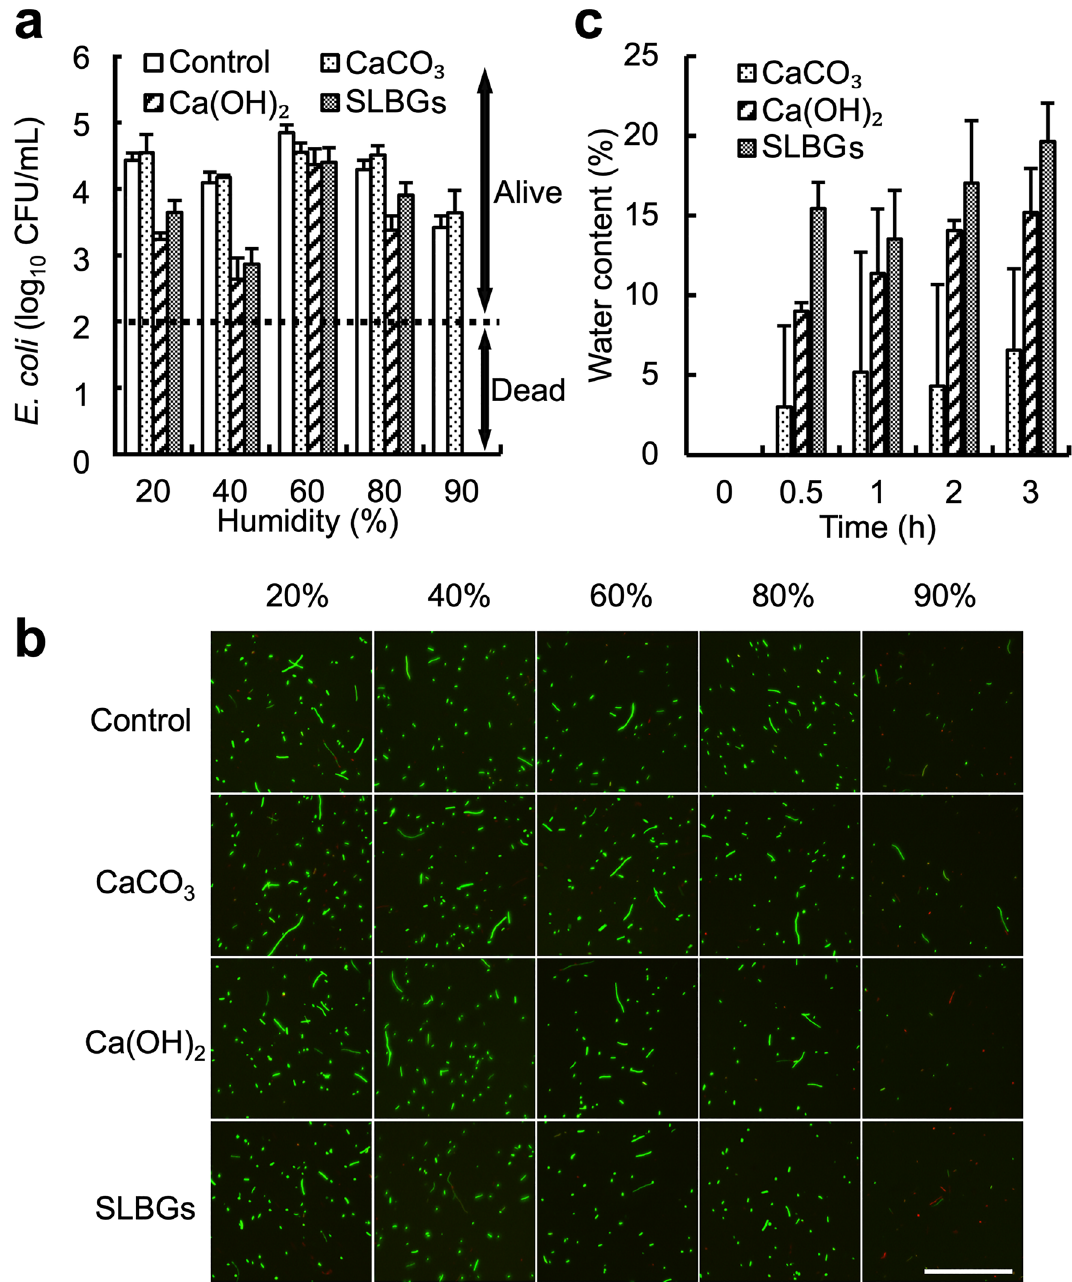
Figure 4. The effect of humidity on disinfection. ( a ) E. coli abundance (log 10 CFU) after contact with disinfectant (control, CaCO 3 , Ca(OH) 2 , or SLBGs) under various humidity conditions (20%, 40%, 60%, 80%, or 90%) for 3 h. The detection limit was 2 log 10 CFU/mL (dashed line). ( b ) Live/dead assay with the disinfectant (control, CaCO 3 , Ca(OH) 2 , or SLBGs) under various humidity conditions (20%, 40%, 60%, 80%, or 90%) after 3 h. Images were captured using a fluorescence microscope equipped with a 20 × objective. Bar, 100 μm. ( c ) Water content of disinfectant (CaCO 3 , Ca(OH) 2 , or SLBGs) over time at 35 °C and 90% humidity. Data in a and c represent the mean and SD (error bars) from three separate